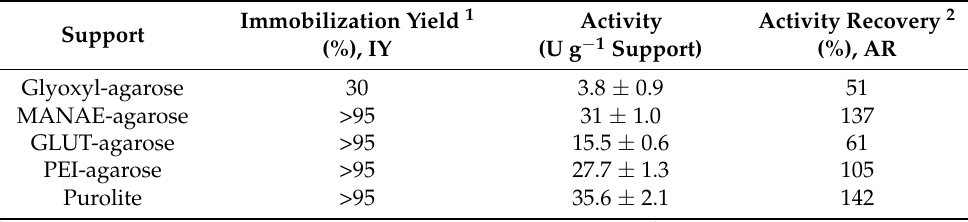
Table 1. Principal parameters for immobilization of the Mpxyn10 on different